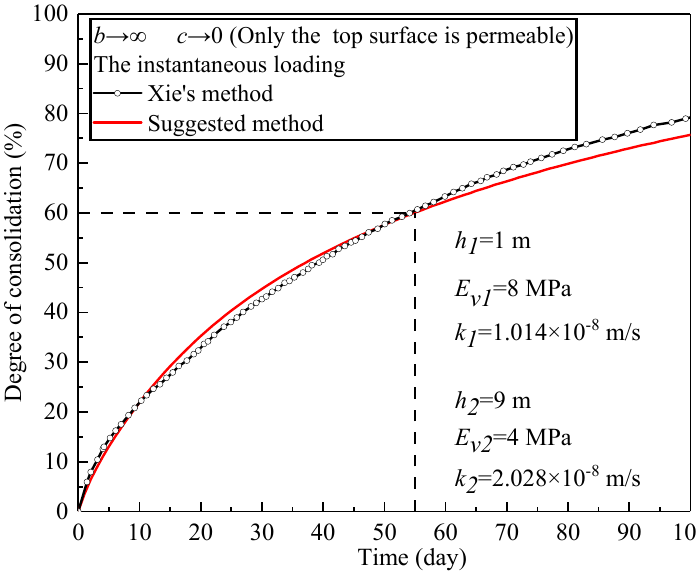
Figure 2. Consolidation curve for the instantaneous loading.